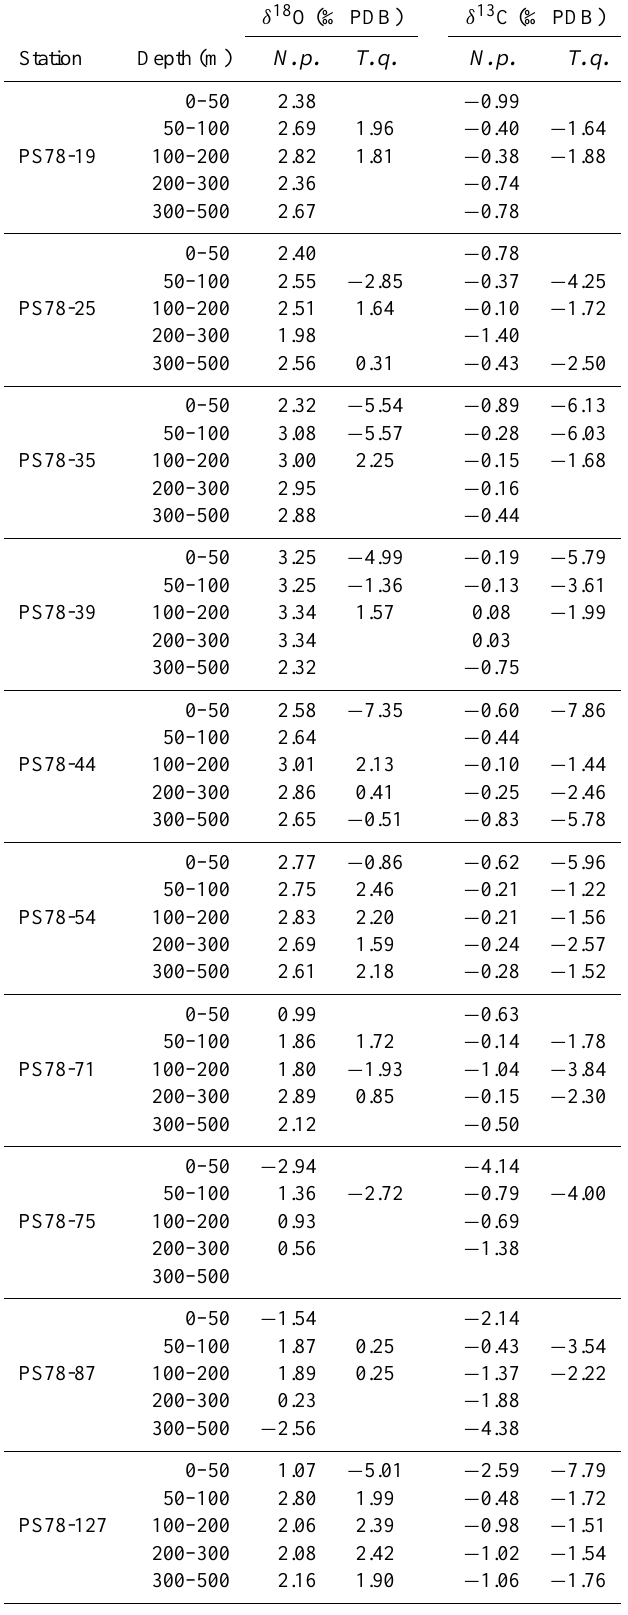
Table 4. δ 18 O and δ 13 C values of N. pachyderma ( N. p. ) and T. quinqueloba ( T. q. ) from plankton